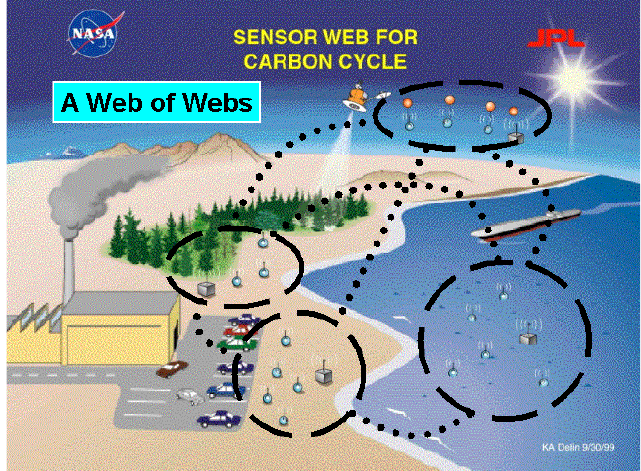
Figure 8. A Macro-Sensor Web comprised of individual webs can collect and process in situ data over vast regions of